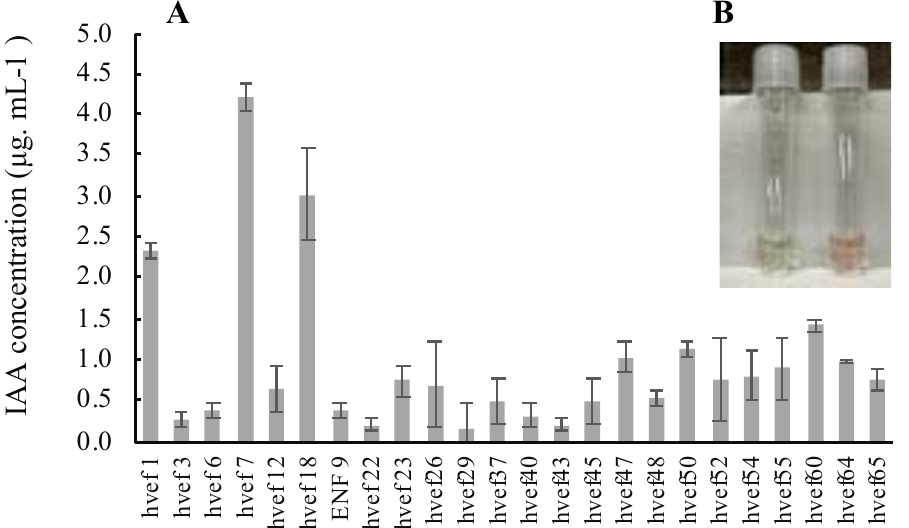
Figure 5. Quantitative ( A ) and qualitative indole-3-acetic acid (IAA) production rates ( B ) caused by 24 isolated fungi after 14 days of incubation. Values are the means of three replicates ± standard deviation.